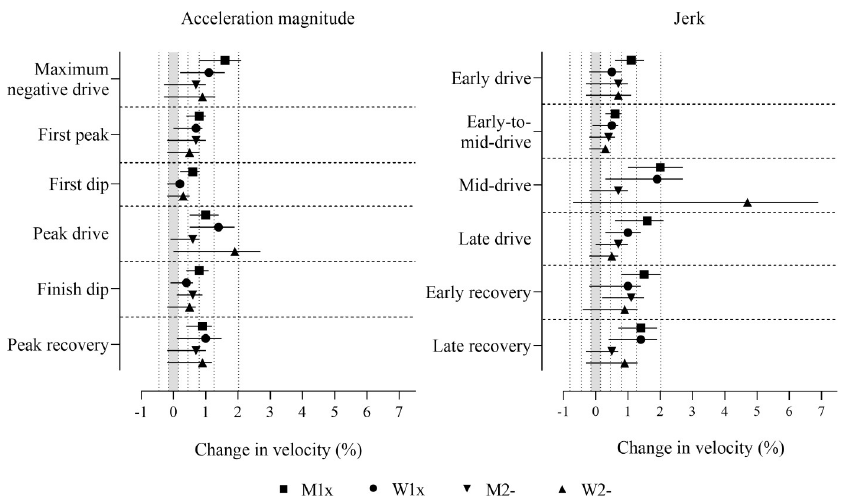
Fig 6. Differences between crews in the effects of the predictor variables with adjustment for power output and stroke rate. Data are SD (%) and 90% compatibility intervals. The shaded grey area covers trivial values (values within the smallest substantial difference thresholds, -0.15 to 0.15%). Vertical dotted lines delineate threshold magnitudes of small ( ± 0.15), moderate ( ± 0.45), large (+0.80), very large (+1.3), and extremely large (+2.0). Effects with compatibility intervals that do not enter the grey area are decisively (very likely or most likely) substantial. Effects with compatibility intervals that end within the grey area have adequate precision (possibly or likely substantial or trivial).